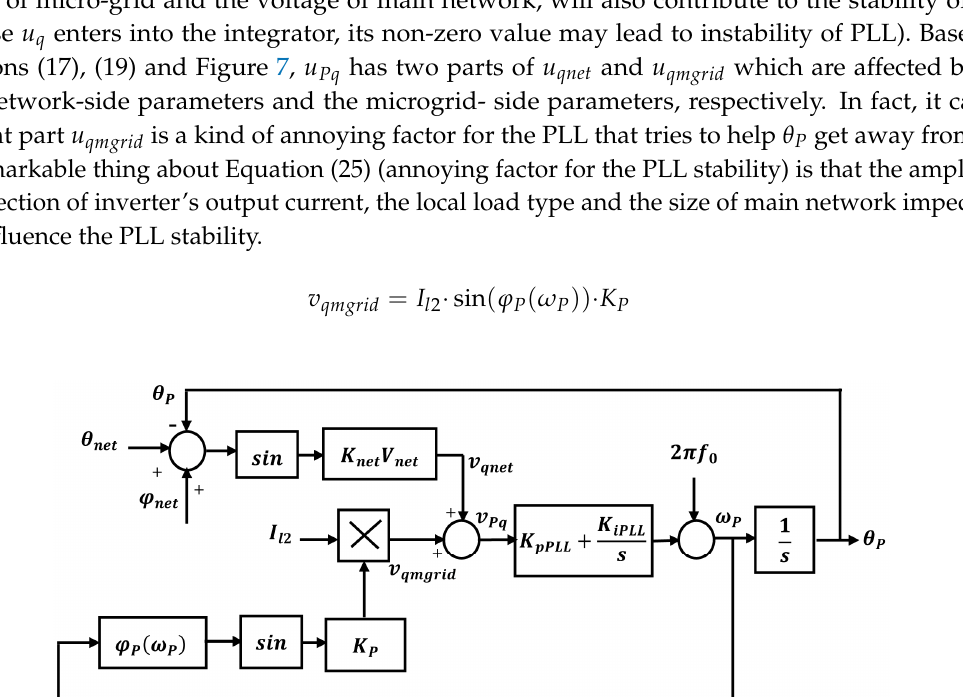
Figure 6. Diagram of network voltage and measured voltage by PLL.